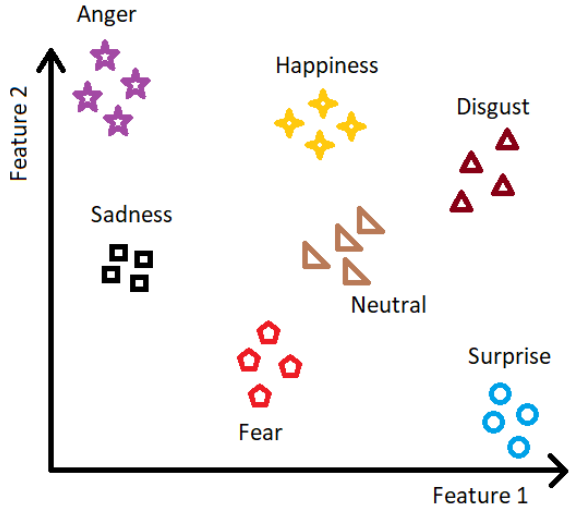
Figure 21. Example of a feature space in an FER